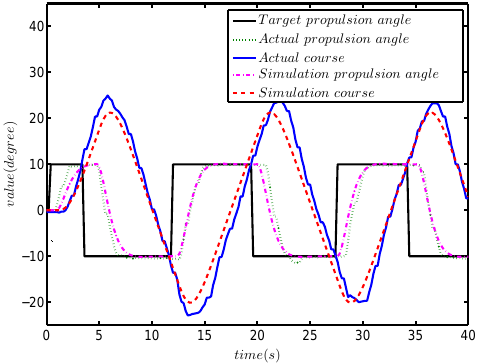
Figure 9. The comparison results of the zig-zag test.